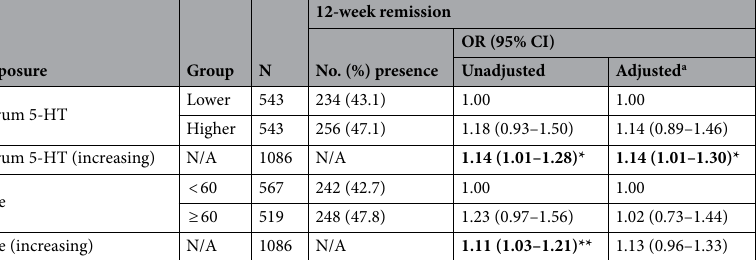
Table 2. Individual effects of baseline serum 5-HT level and age on 12-week remission. Significant values are in bold. a Adjusted for education, living alone, religious observance, melancholic features, atypical features, age at onset, duration of present episode, HAMD, HADS-A, and SOFAS. *P < 0.05; **P <